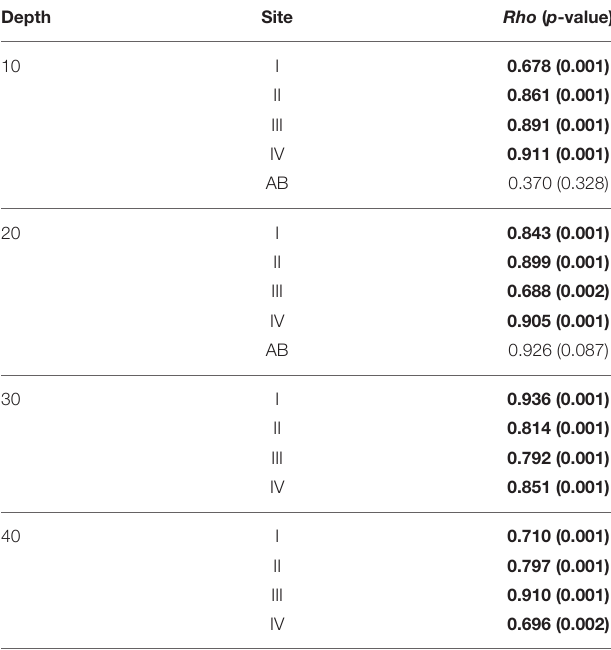
TABLE 2 | Linearity of community development over time for each individual quadrat by depth.